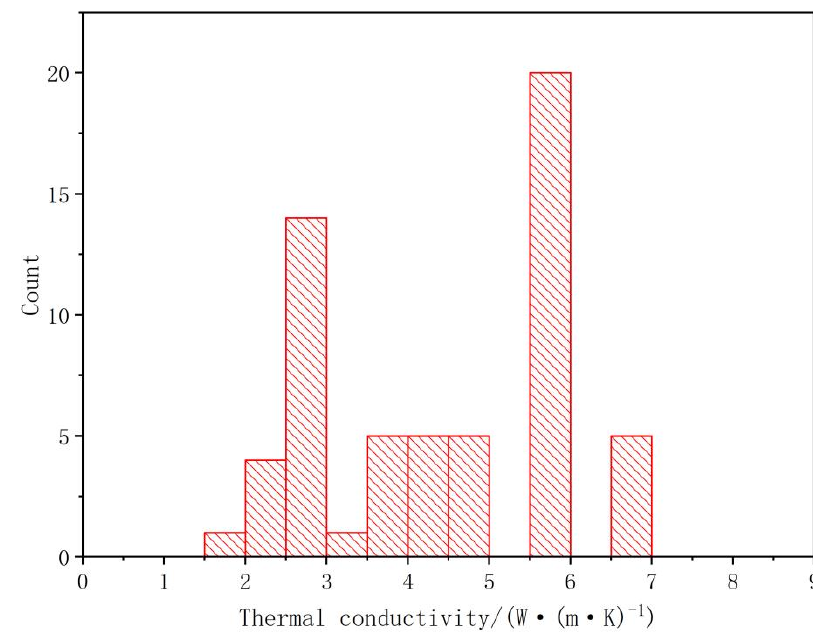
Figure 8. Histogram of rock thermal conductivity. Table 4. Rock thermal properties results.